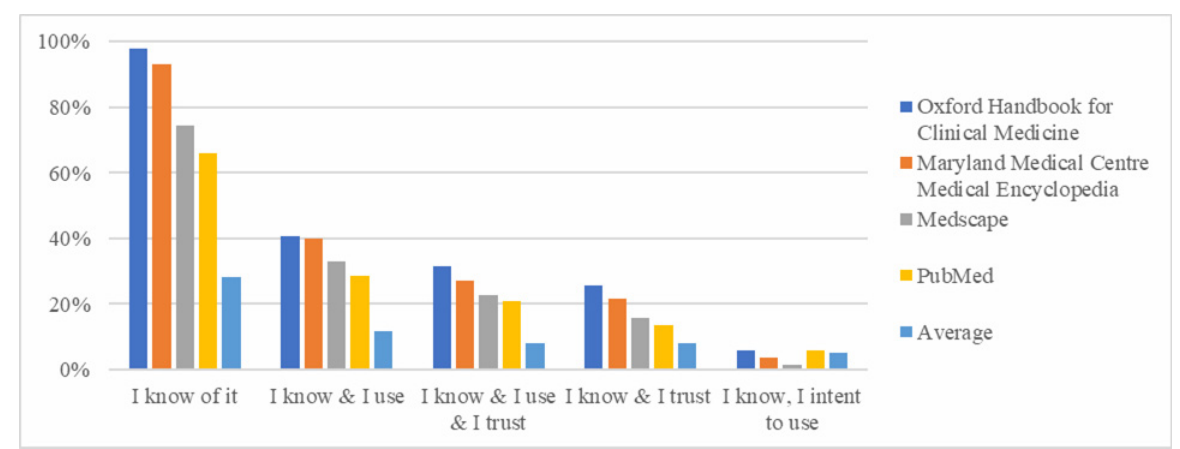
Figure 3. Most known and used apps